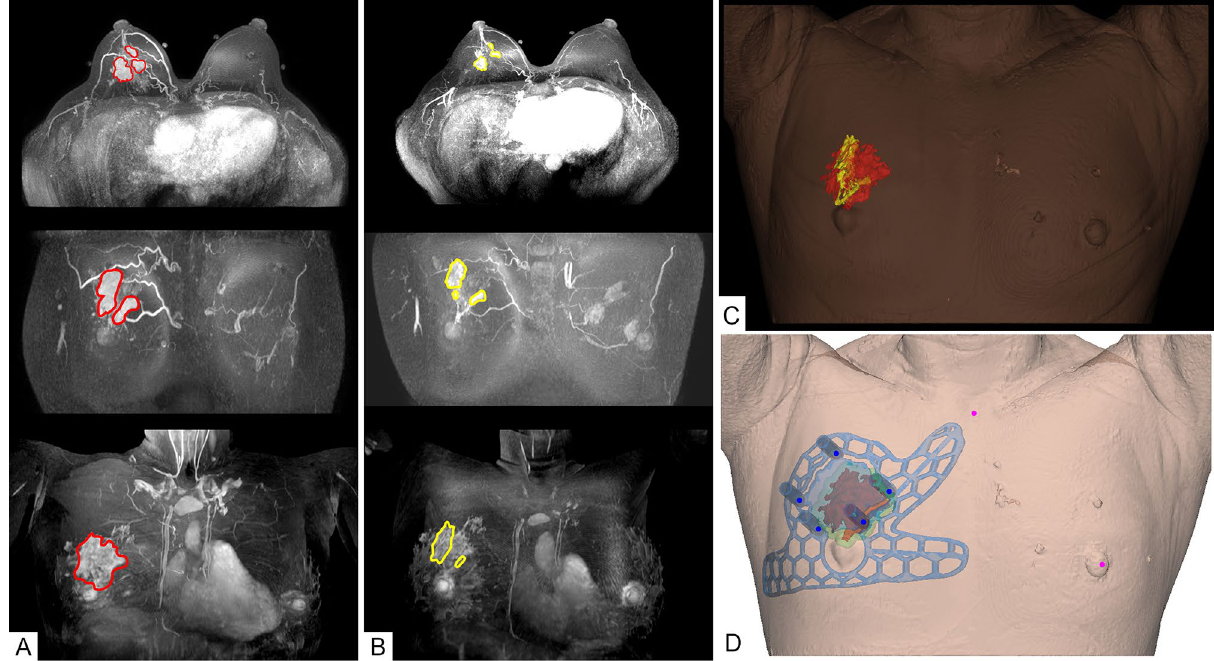
Figure 1. Three-dimensional modeling of the breast and tumor area based on magnetic resonance imaging (MRI) in neoadjuvant systemic therapy (NST) patient and patient-specific tumor target 3D printed-breast surgical guide (3DP-BSG) modeling. ( A ) 3D modeling of the breast and tumor area using MRI before NST. ( B ) 3D modeling of the breast and tumor area using MRI after NST. ( C ) 3D modeling of the breast and tumor area using MRI fusion of the images obtained before and after NST. D. Patient-specific 3D-BSG modeling using three-dimensional information about breasts and